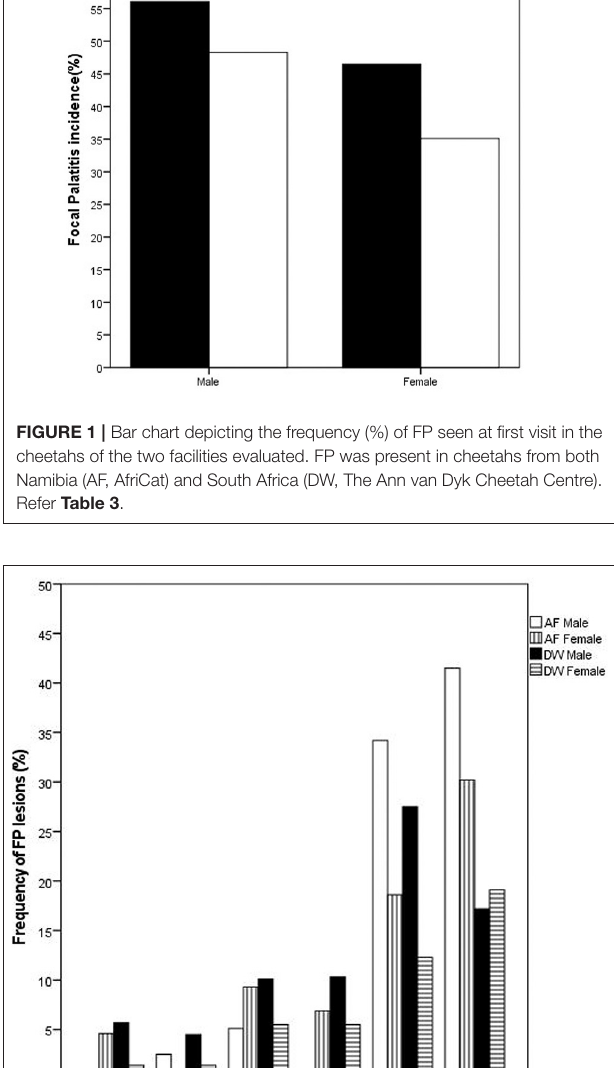
TABLE 2 | Descriptive statistics of the number of cheetahs, sex, and the number of visits per cheetah as well as per facility. AfriCat